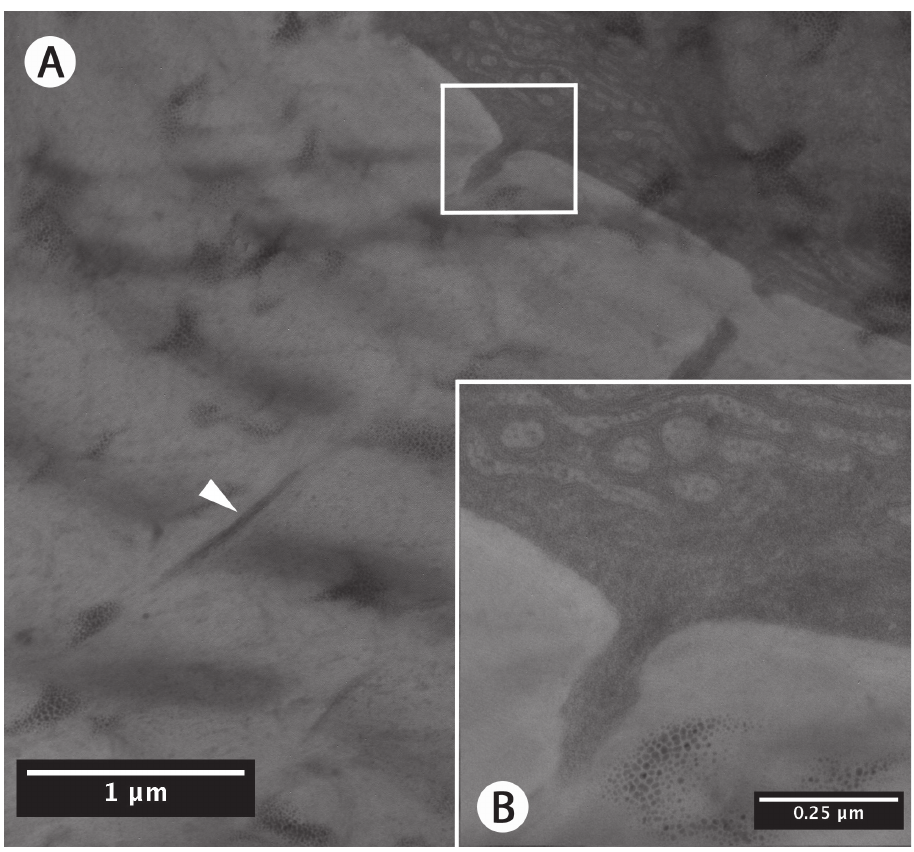
Figure 9. A TEM image of the class one gland cells found underneath the synsternal translucent patch in a Dendrocerus sp. (Hymenoptera: Megaspilidae) The arrow points to the secretory duct in the cuticle, while the square outlines the gland cells at the base of these ducts B A closer look at the class one gland cells at the base of one of these ducts. Specimen identifier: IM